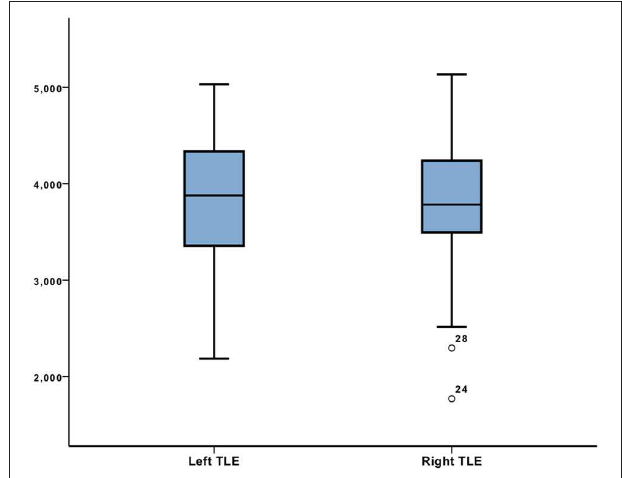
FIGURE 1 | Right hippocampal volume comparison between left TLE and right TLE adjusted for HS with